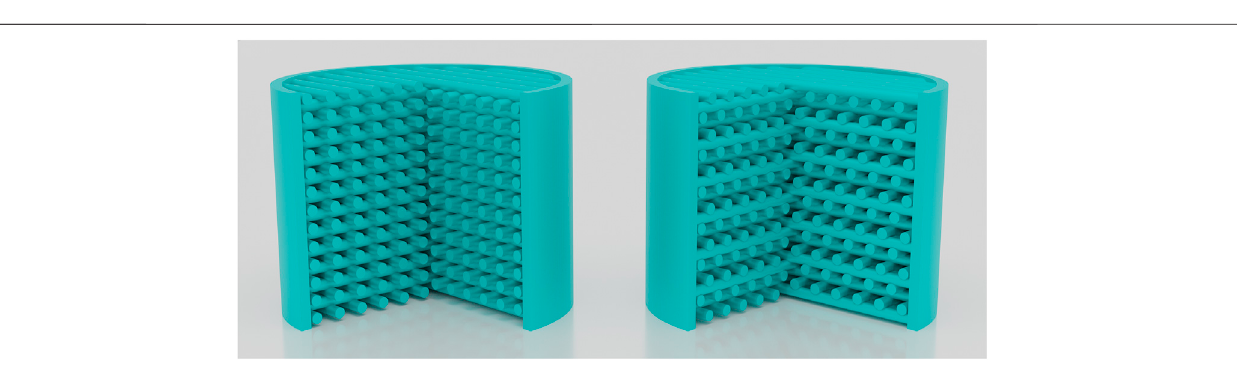
FIGURE 6 | Impression of the two variations of 3D-printed logpile structures, straight on the left side and staggered on the right side.